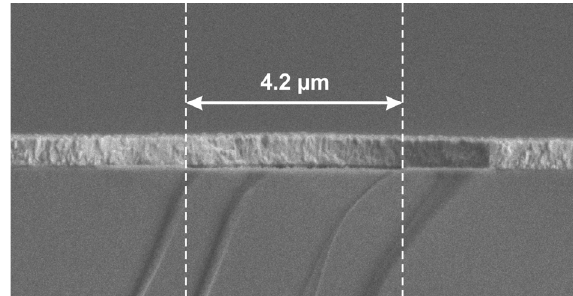
Fig. 3. SEM image of cross section through bulge after rear- side irradiation slightly below ablation threshold.